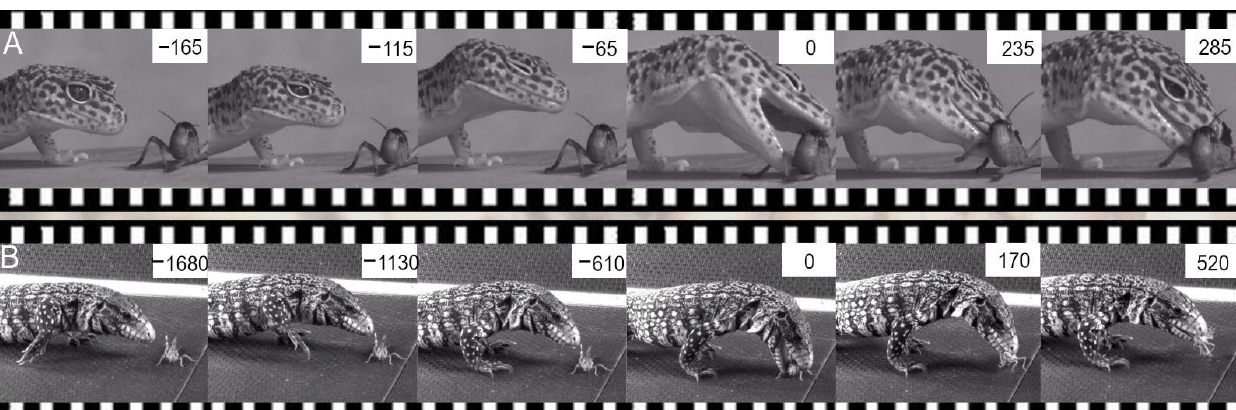
Figure 12. Two examples of successive images of jaw prehension in two highly different species showing the stereotyped lunge phase to catch insects. ( A ) Eublepharis macularius . ( B ) Tupinambis